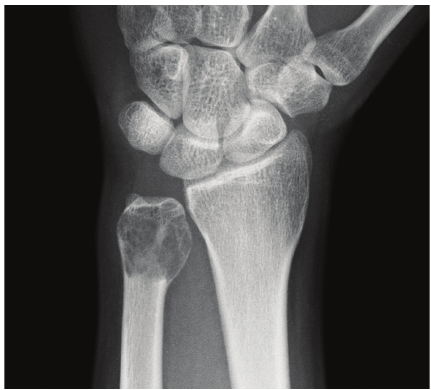
Figure 1: Preoperative plain X-ray showed an expansile, multilob- ular, and radiolucent lesion with a clear margin in the distal end of the left ulna.